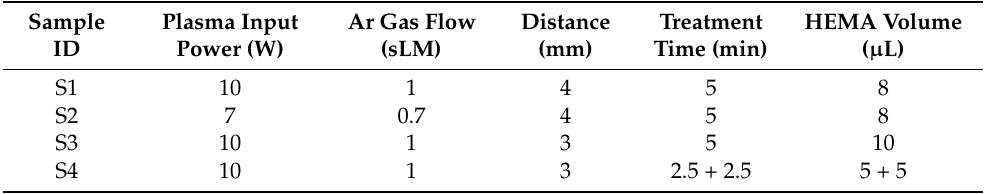
Table 1. Sample identifier (ID) employed in this work and corresponding process parameters for the generation of HEMA-based